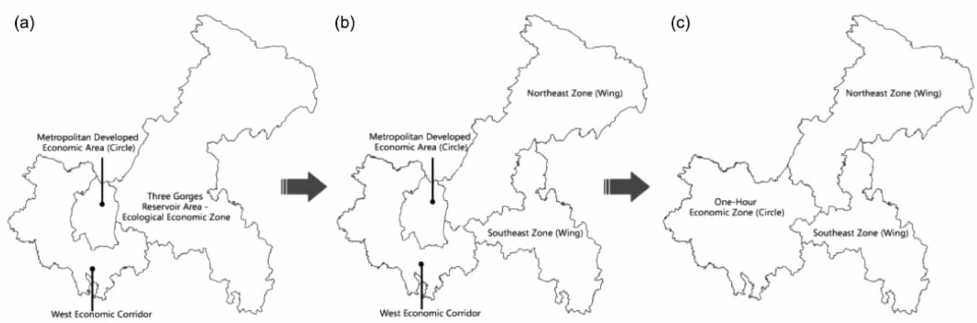
Figure 3. Evolution of Chongqing’s spatial development strategy: ( a ) the “Three Economic Zones” (3EZs) strategy; ( b ) the “Partition of Four Economic Zones (2003–2020)” strategy; ( c ) the “one circle, two wings” spatial strategy. Source: Chongqing Master Plans (1996–2020, 2003–2020, 2007–2020, 2011 revision); edited by the